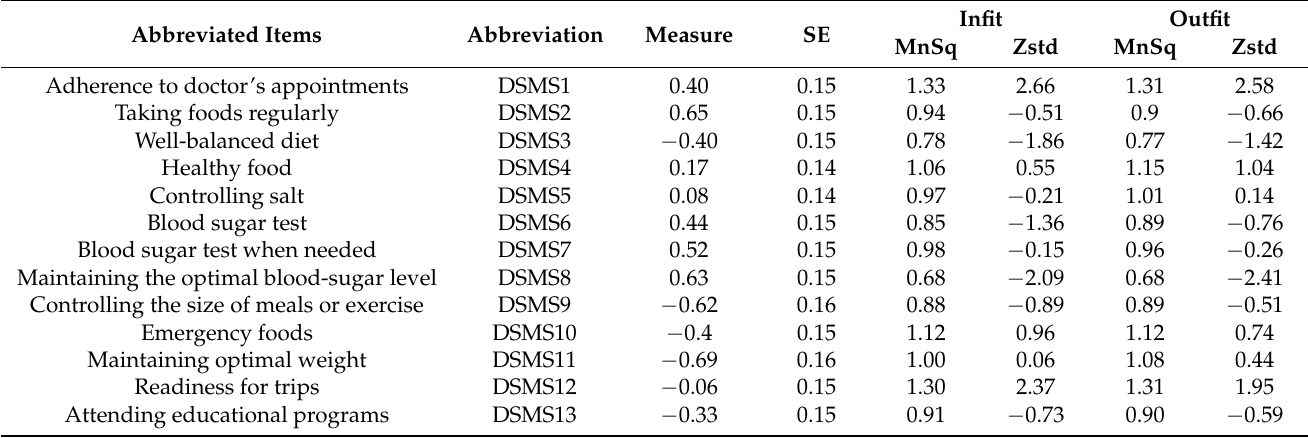
Table 3. Item fit